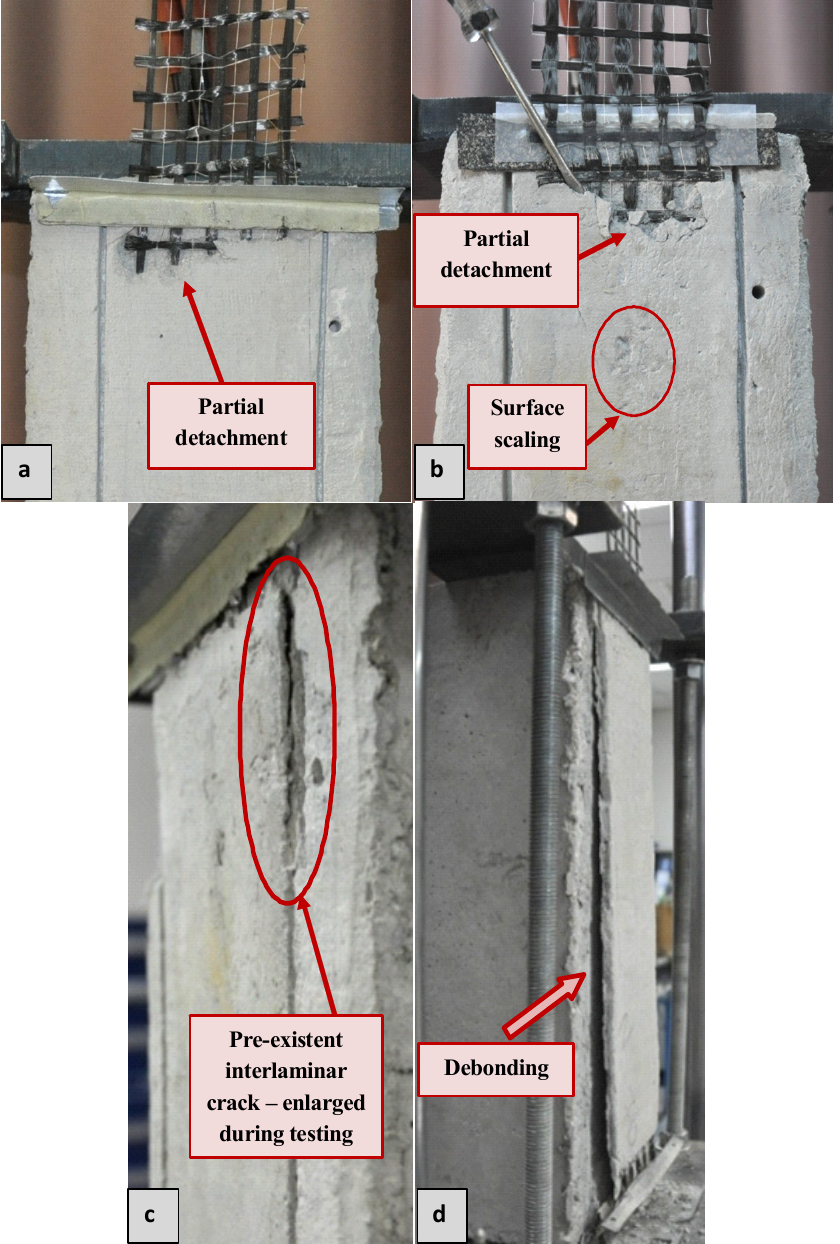
Figure 6. Post-failure photos of ( a ) FT10ML02, ( b ) FT30ML02, ( c ) FT50ML01, and ( d ) FT70MN01 specimens.